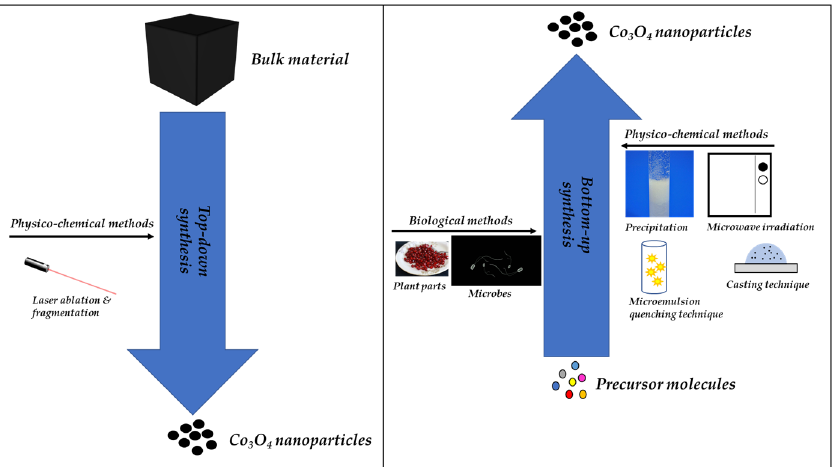
Figure 1. Overview of synthesis methods for cobalt oxide (Co 3 O 4 ) nanoparticles.